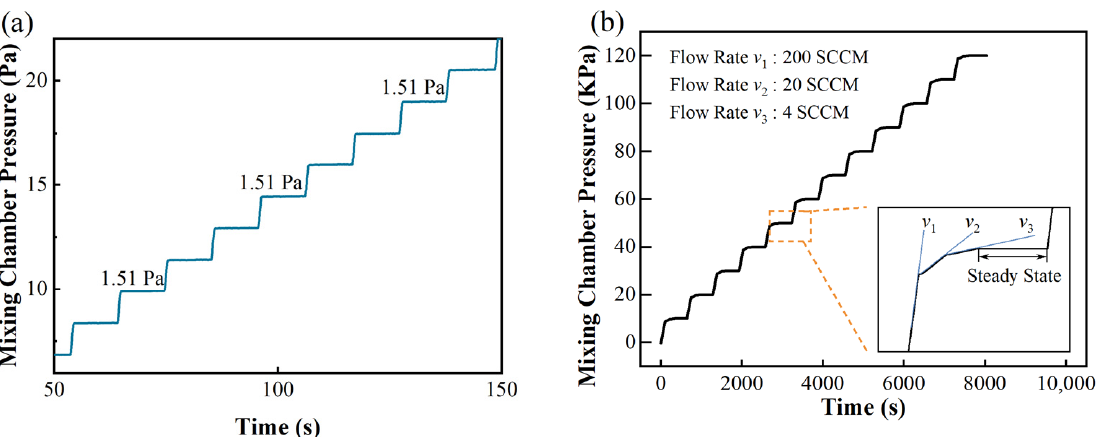
Figure 3. ( a ) Examination of partial pressure control limit and ( b ) three-level flow control method for precise and efficient partial pressure control.